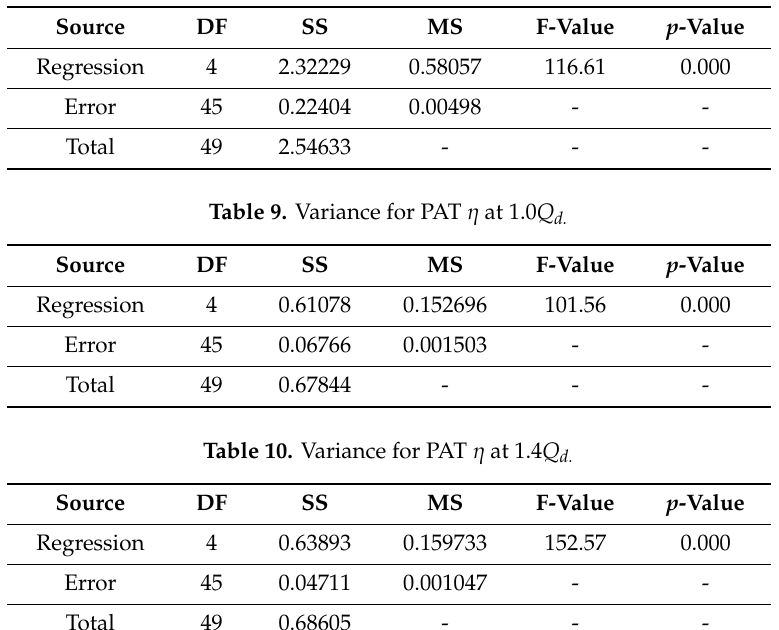
Table 8. Variance for PAT η at 0.6 Q d.